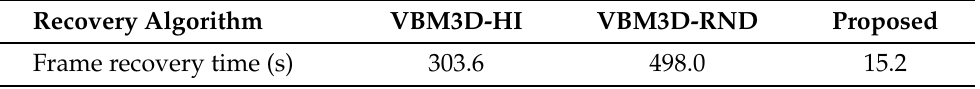
Figure 7. PSNR improvements related to [21] for thresholding using VBM3D-HI, VBM3D-RND, and the proposed randomized thresholding. Table 3. An average frame recovery time for VBM3D and the proposed algorithm on a 2.8 GHz